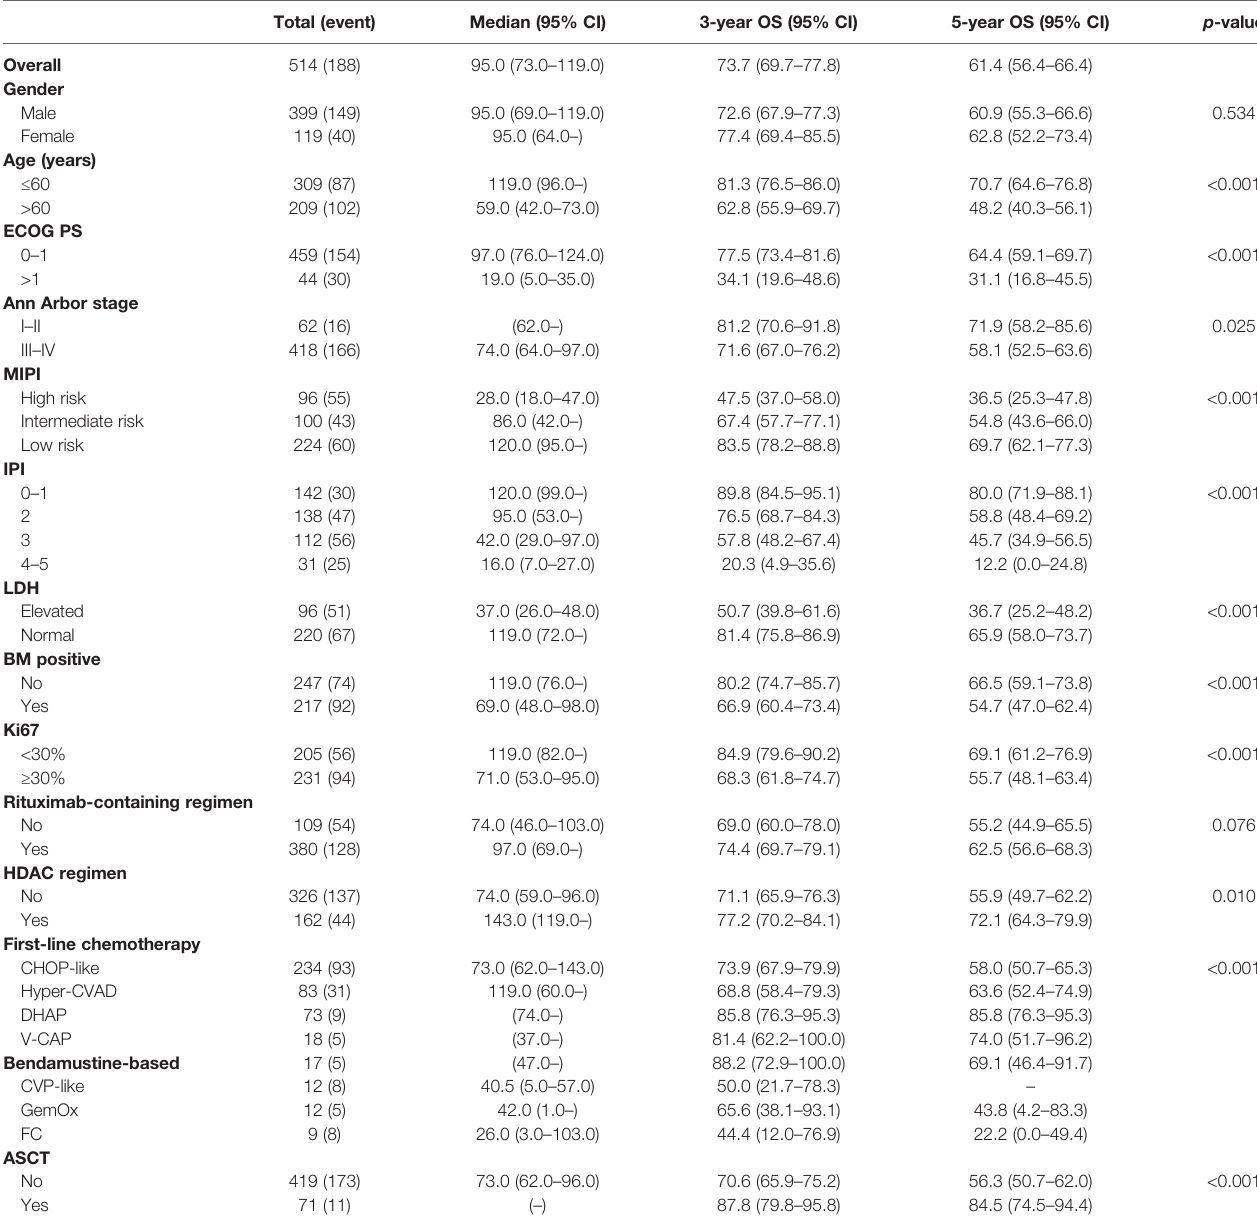
TABLE 3 | Overall survival (OS) strati fi ed by clinical features and therapy strategies in mantle cell lymphoma